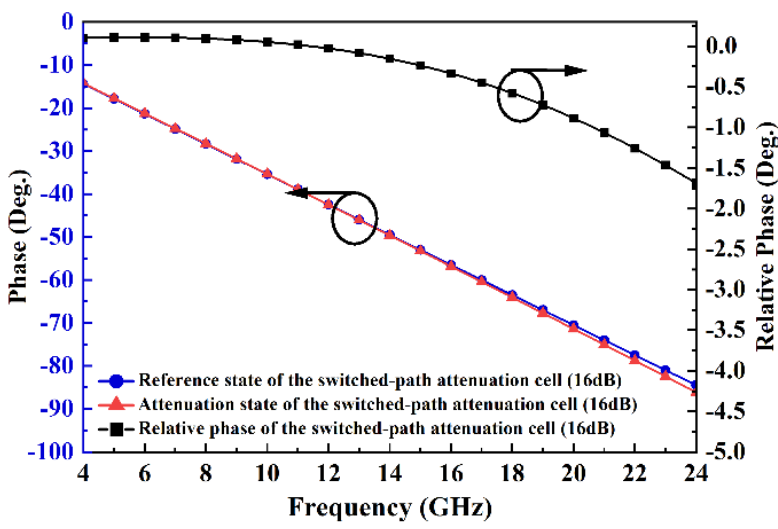
Figure 12. The phase variation between the reference state and the attenuation state of the switched − path attenuation